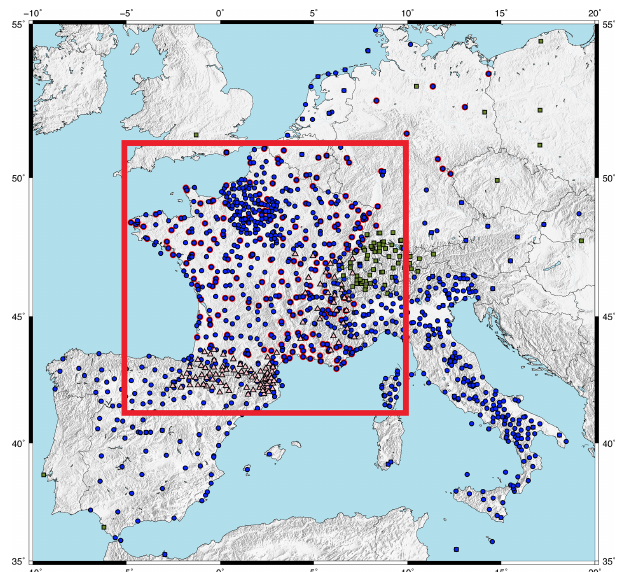
Figure 2. Distribution of the permanent (blue circles and blue cir- cles with red outline for the stations used to define the “France- centered” reference frame) and campaign (pink triangles) stations used in this study. Green squares are combined Swiss stations.The red frame corresponds to the study